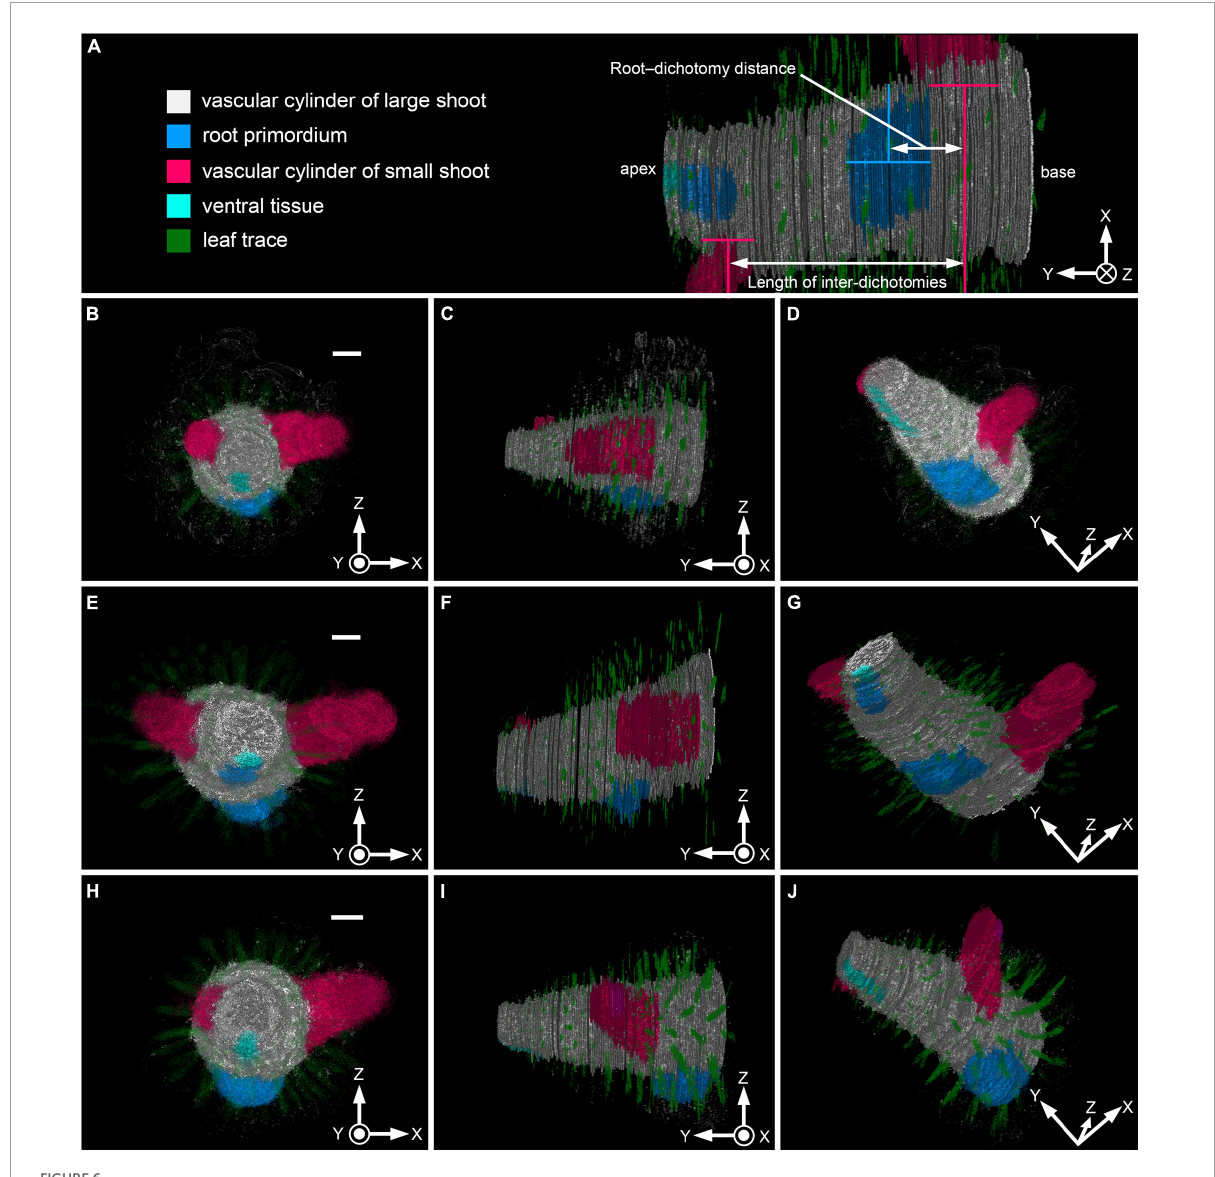
FIGURE6 3D images of vascular cylinders and root primordium in Lycopodium clavatum shoots. Sample numbers correspond to those in Supplementary Tables 1 , 2 . (A) Color legends and diagrammatic representation of the measurements. 3D image of sample #P3 viewed from below. (B,E,H) Front view. (C,F,I) Side view. (D,G,J) Oblique downward view. (B–D) 3D images of shoots shown in Figures 2A–F (sample # P1). A total of 222 images were used for the reconstruction, which included 31 blanks. Each section is 5 µ m thick. (E–G) 3D images based on shoot shown in Figures 3C,D (sample # P3). A total of 313 images, including 120 blanks, were used. Each section is 5 µ m thick. (H–J) 3D images based on sample # P5, consisting of 260 images, including 44 blanks. Each section is 4 µ m thick. Scale bars, 200 µ m in (B,E,H) . Coordinate axes ( X , Y , and Z ) are indicated on the bottom-right corner of each panel. Concentric circle: axis perpendicularly out of the panel plane; circle with cross-mark: axis perpendicularly into the panel plane.